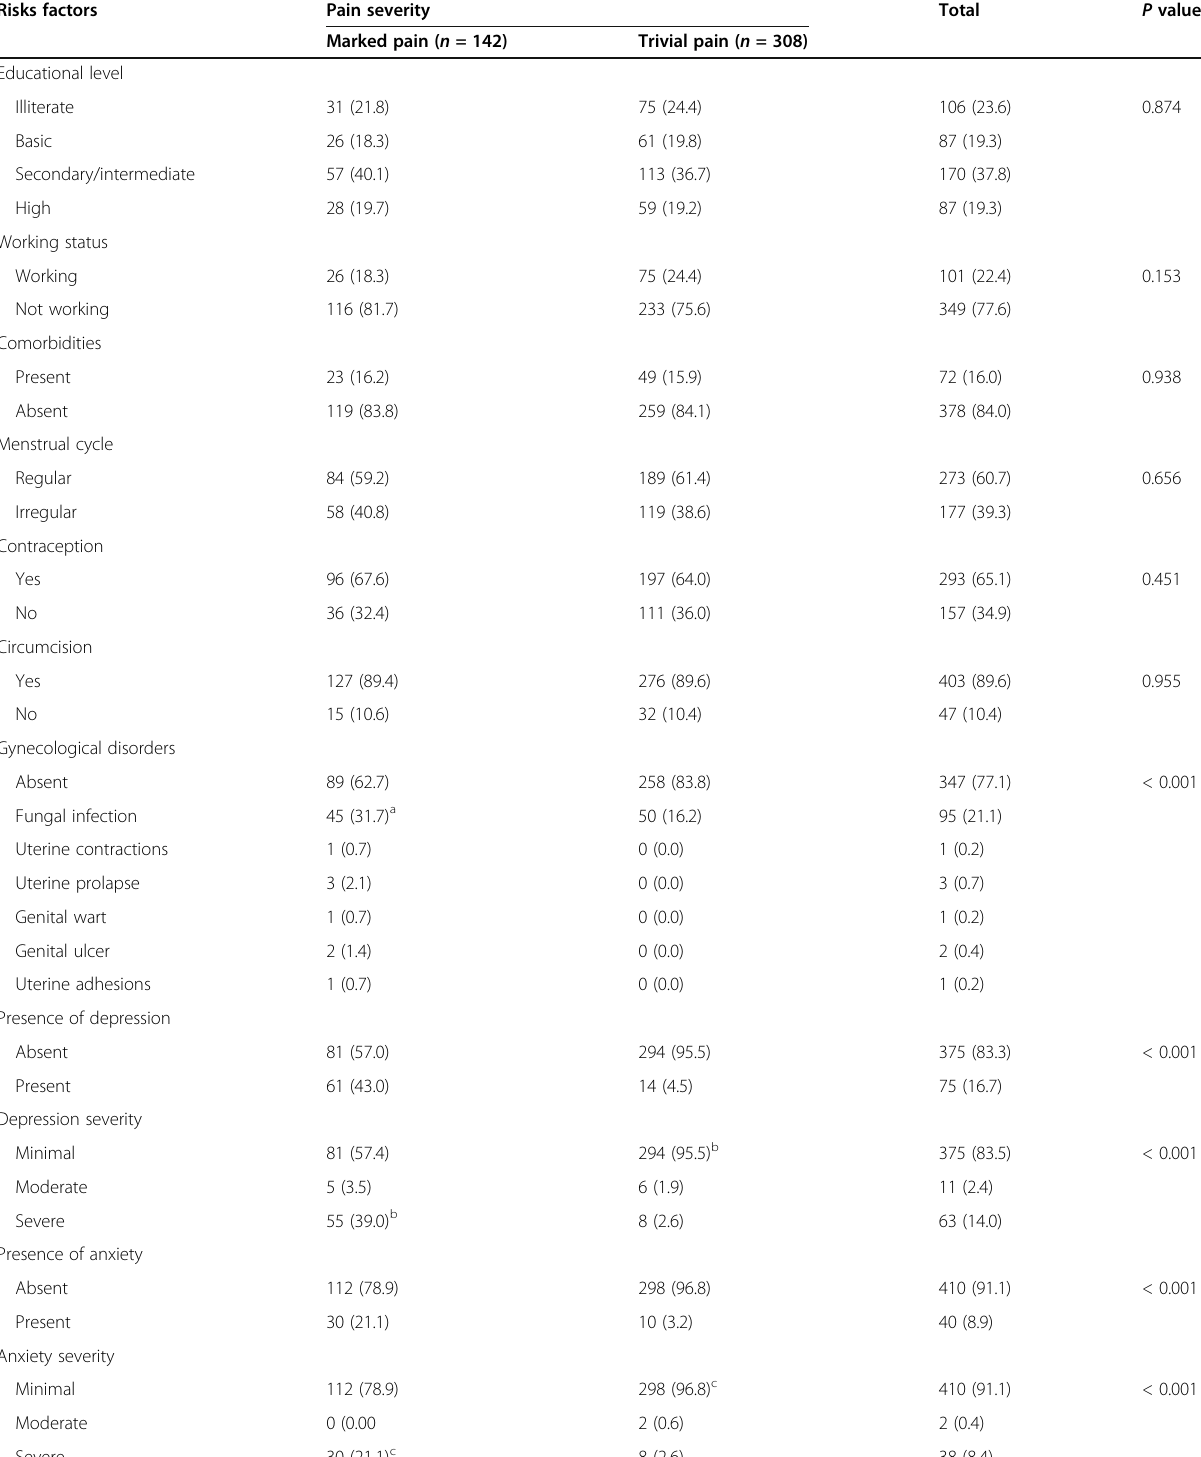
Table 4 Relation between pain severity and different risk